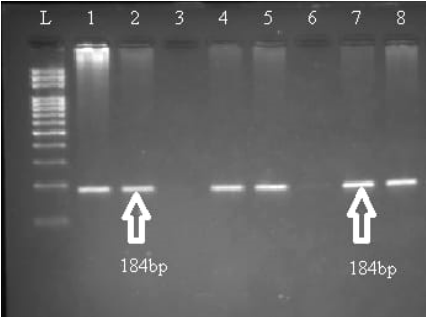
Figure 1. TNF- α genotyping using AS-PCR. Lane L: 100 bp DNA molecular weight marker. Lanes 1, 5 and 7: allele G is represented by the presence of a 184 bp PCR fragment. Lanes 2, 4 and 8: allele G is represented by the presence of a 184 bp PCR fragment. Each set of two lanes represents one sample: lanes 1 and 2, heterozygous (GA); lanes 3 and 4, homozygous (AA); lanes 5 and 6, homozygous (GG); lanes 7 and 8, heterozygous (GA).